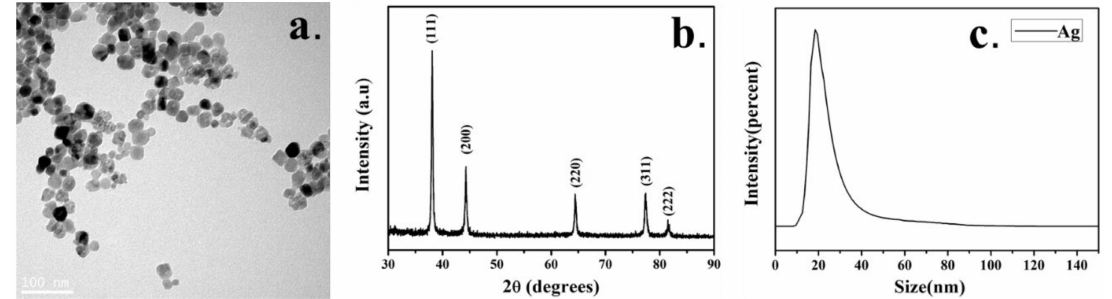
Figure 1. Characterization of nano-Ag. ( a ) Transmission electron micrograph; ( b ) XRD pattern. ( c ) Granularity analysis.